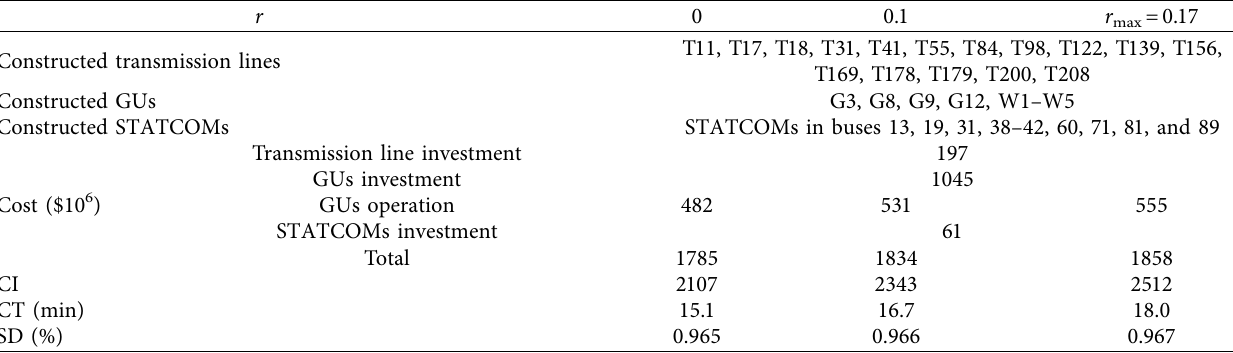
Figure 3: Values of technical indices for the different uncertainty levels and Δϑ Table 6: Planning, economic status, and convergence results for the different uncertainty levels and Δϑ